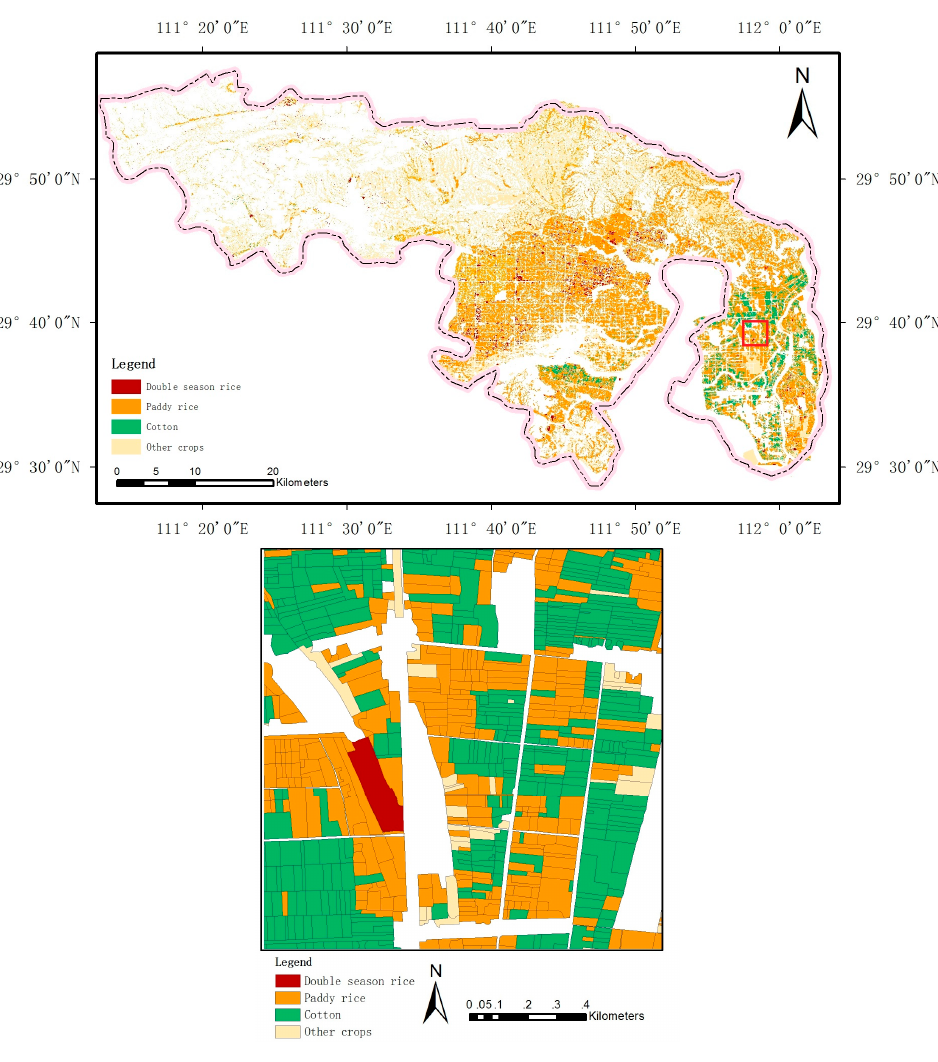
Figure 12. Map of double season rice, paddy rice and cotton (paddy rice includes single season rice and rice rotated with cole).